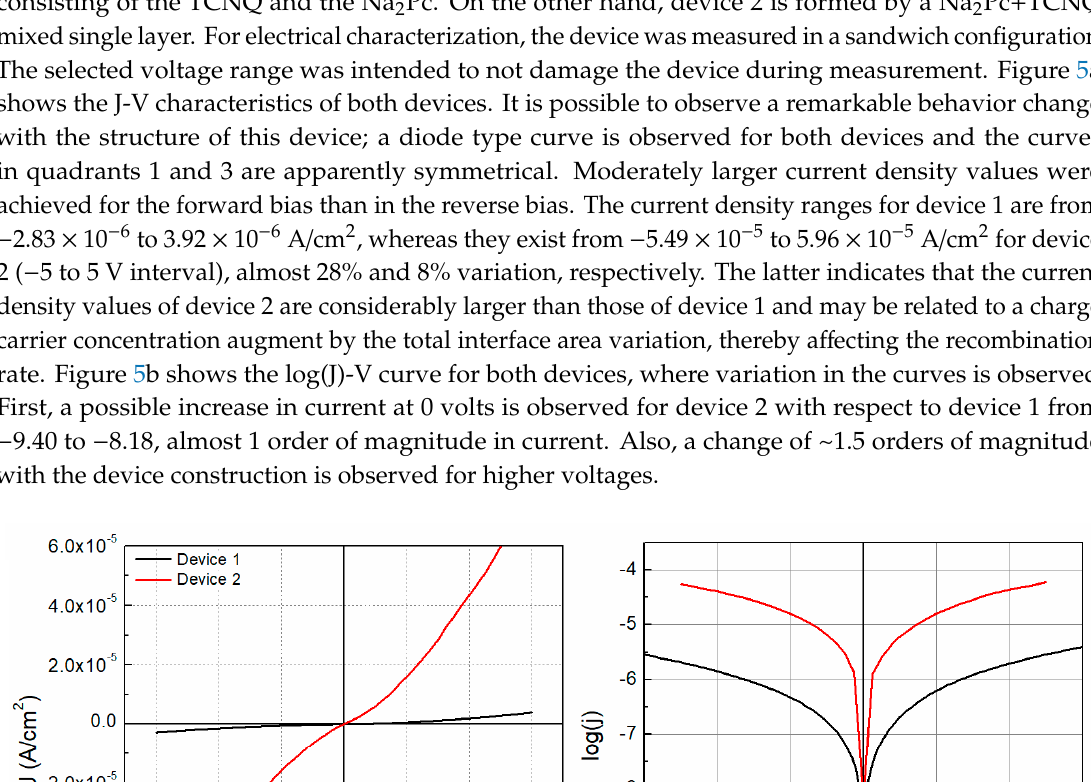
Figure 4. IR spectrum of Na 2 Pc+TCNQ and TCNQ in ( a ) the 700–2250 cm − 1 region and ( b ) the cyano- stretching region.